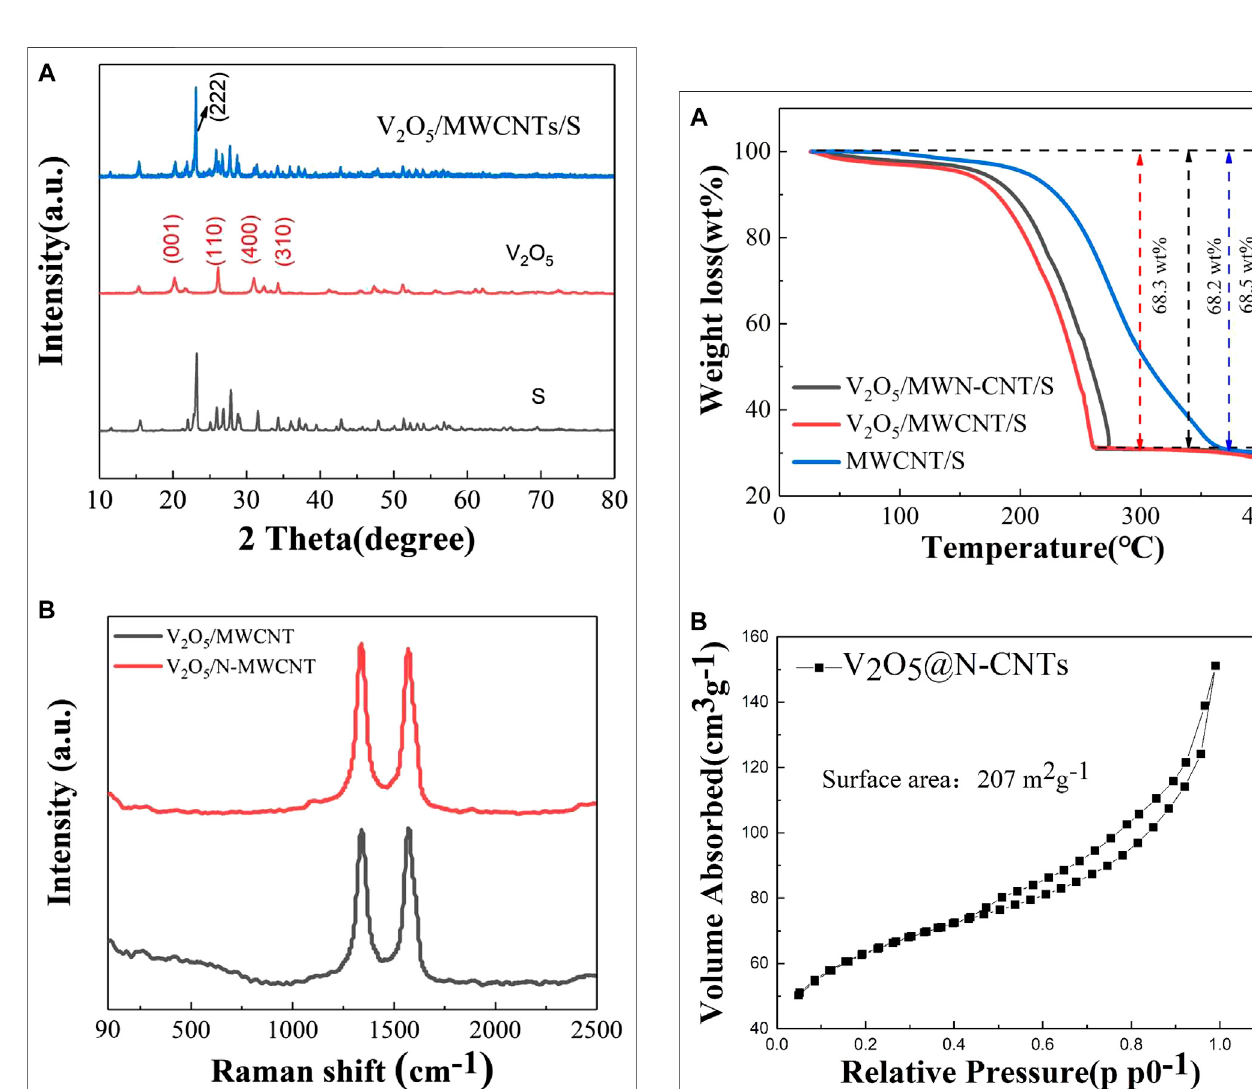
FIGURE 3 | (A) XRD patterns of the V 2 O 5 /MWCNT/S composite material, V 2 O 5 , and sulfur samples, and (B) Raman spectra of the V 2 O 5 / MWCNT and V 2 O 5 /N-MWCNT composite materials.